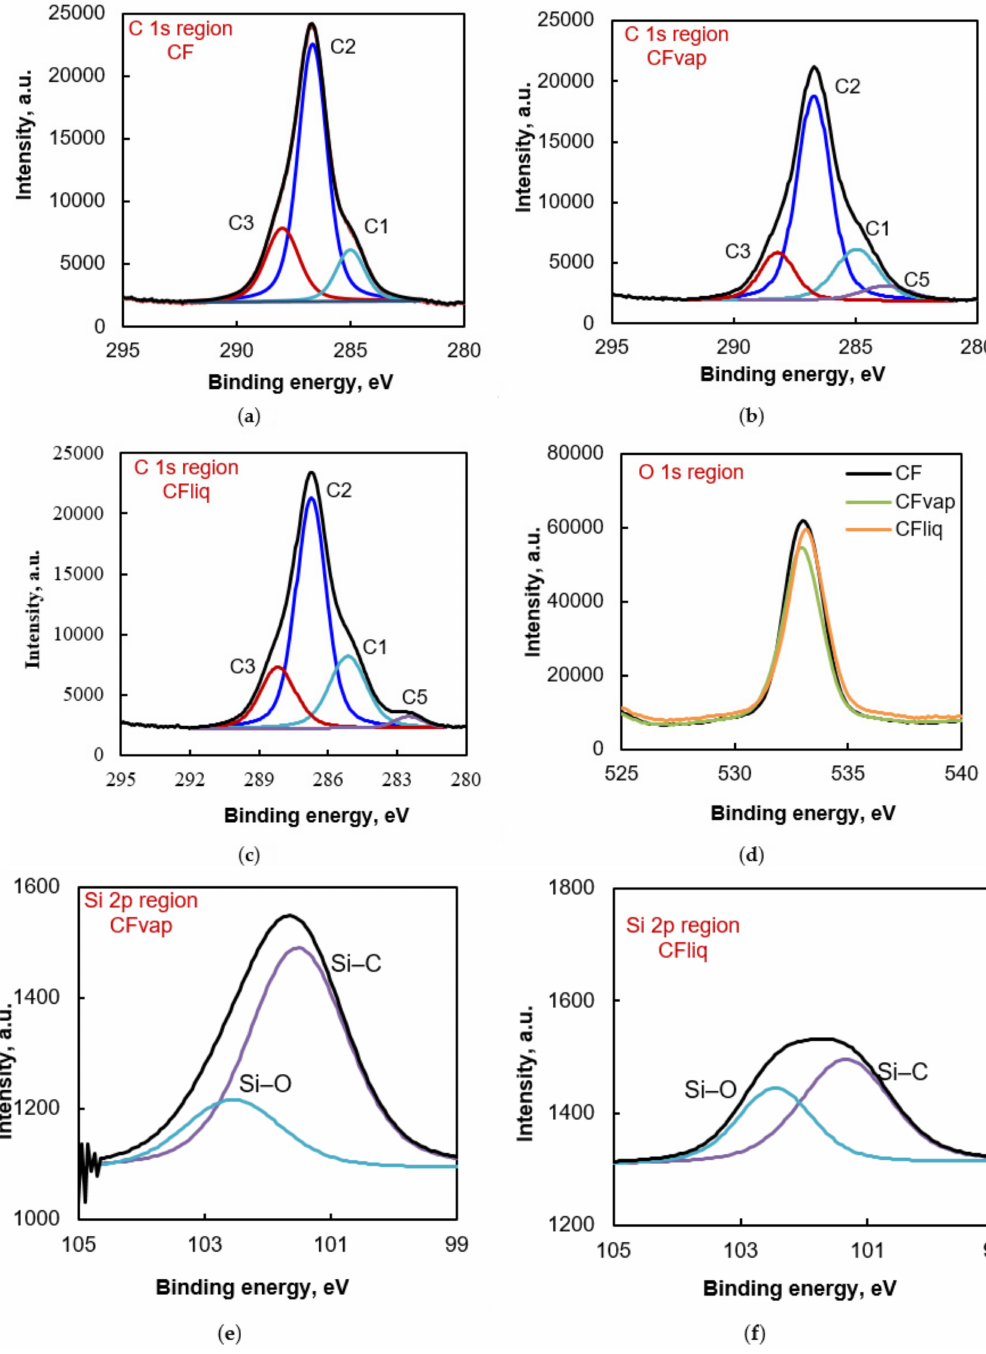
Figure 7. High-resolution XPS spectra for the untreated and silylated CFs: ( a – c ) C 1s peak; ( d ) O 1s peak; ( e , f ) Si 2p